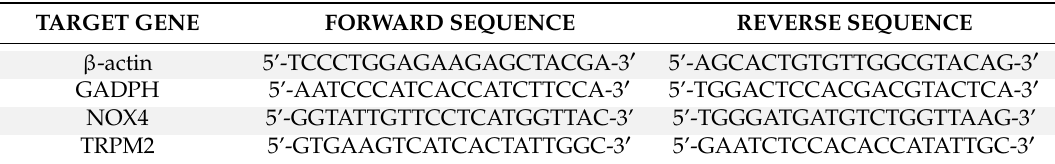
Table 1. Sequences of primers used for